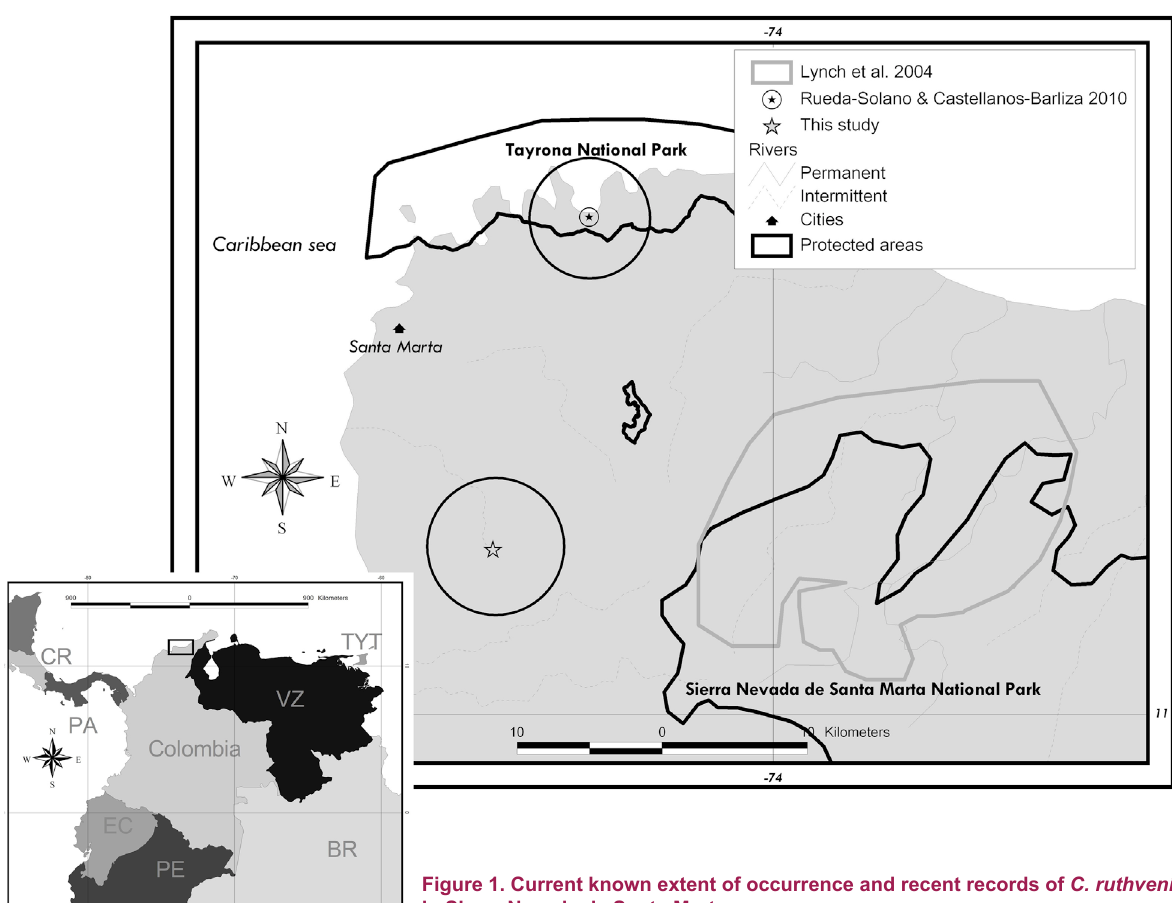
Figure 1. Current known extent of occurrence and recent records of C. ruthveni in Sierra Nevada de Santa